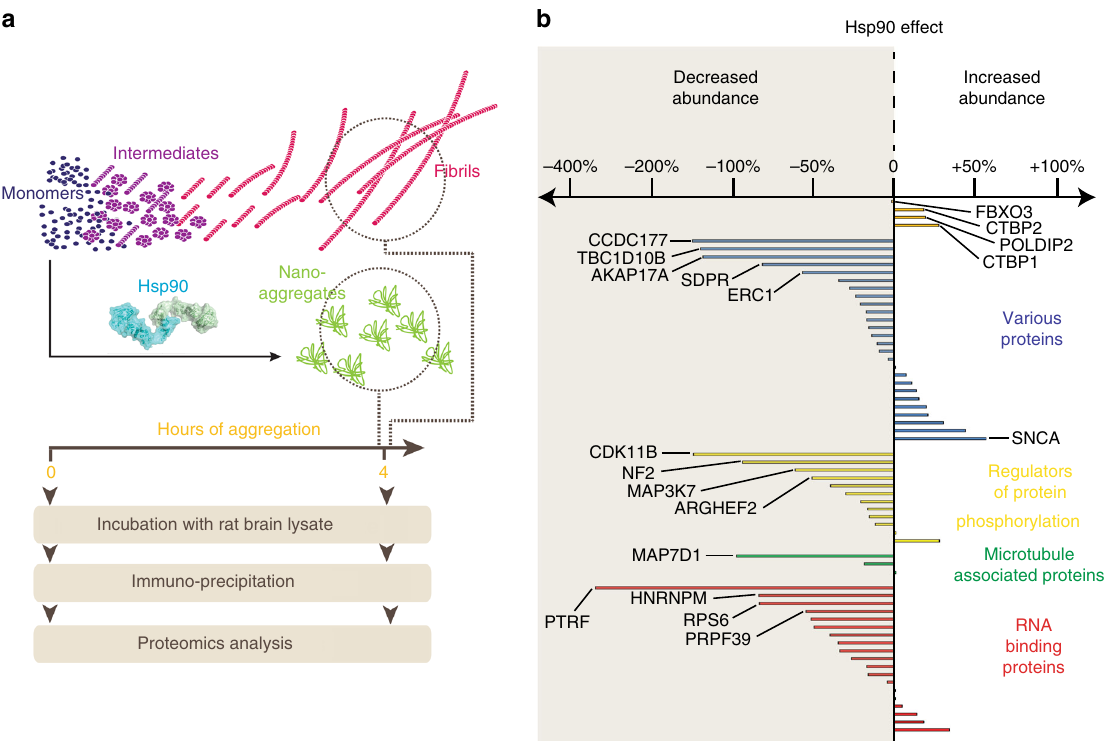
Fig. 6 Hsp90 remodels Tau aggregation-speci fi c interactome. a Experimental setup to compare interactome changes in the presence or absence of Hsp90. b Bar graph showing Hsp90-dependent modulation of Tau-RD* aggregation re fl ected as differences in enrichments for speci fi c proteins sequestered by Tau-RD* fi brils in the presence/absence of Hsp90. Proteins are clustered in colored functional clusters as for Fig. 2c and d. See also Supplementary Data